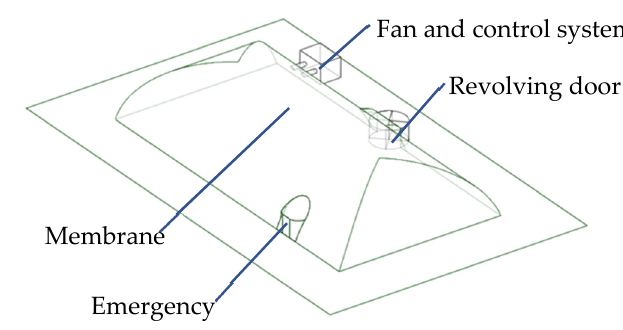
Figure 1. Composition of air-supported membrane structure.